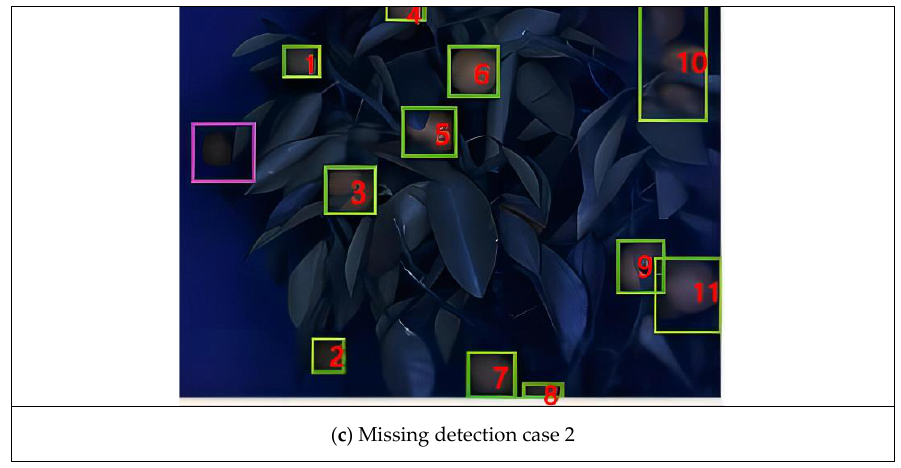
Figure 14. The number in the box shows the detection effect of the corresponding citrus area in the UV image.